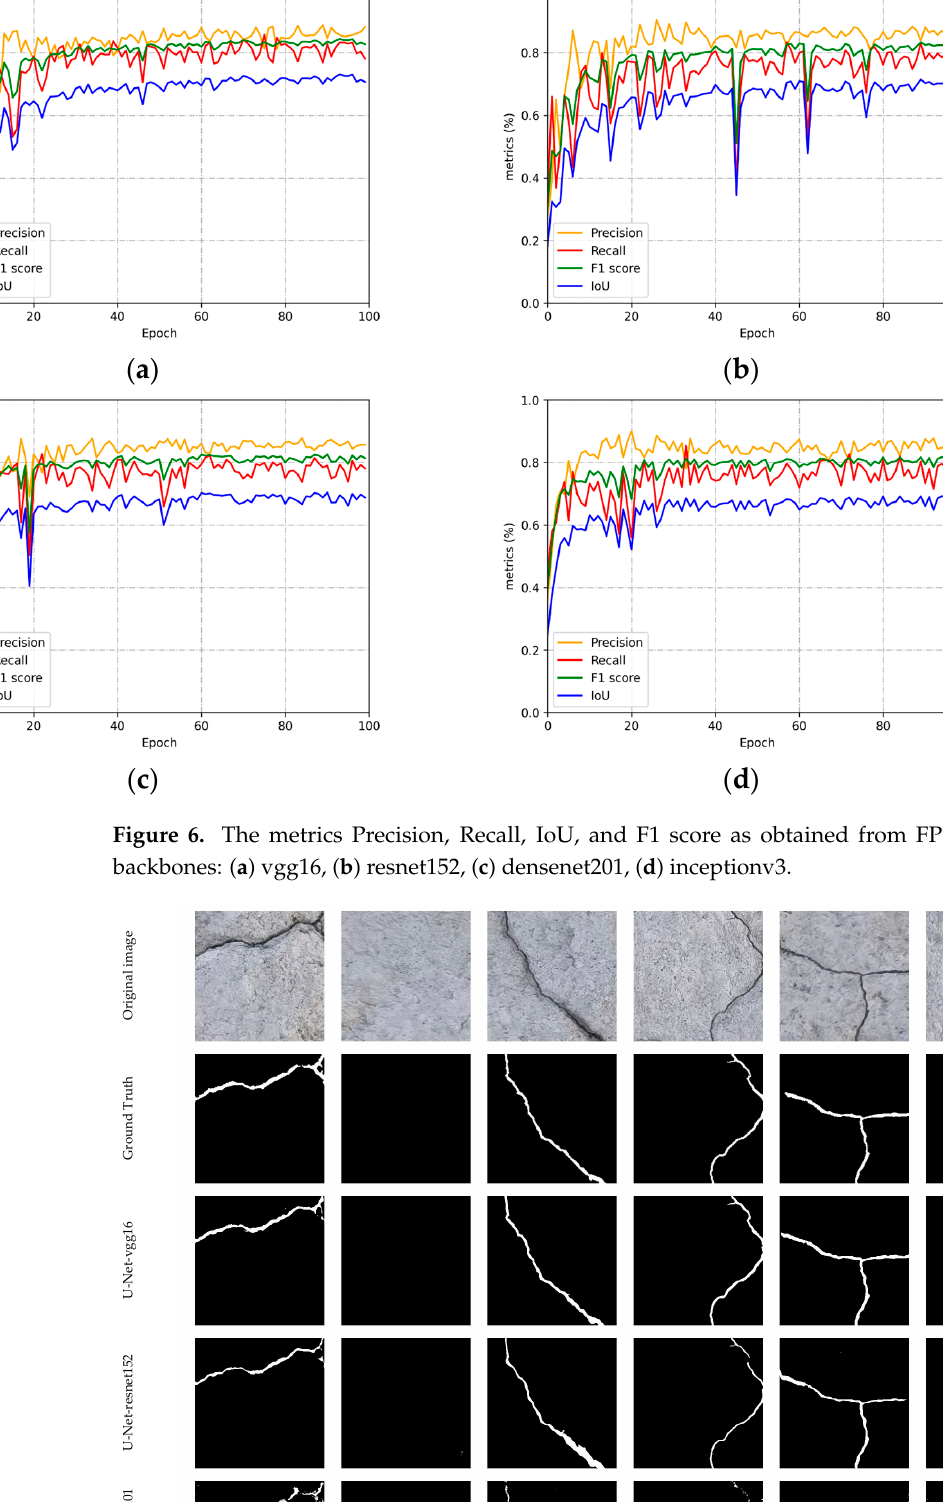
Figure 5. The metrics Precision, Recall, IoU, and F1 score as obtained from Linknet for different backbones: ( a ) vgg16, ( b ) resnet152, ( c ) densenet201, ( d ) inceptionv3.